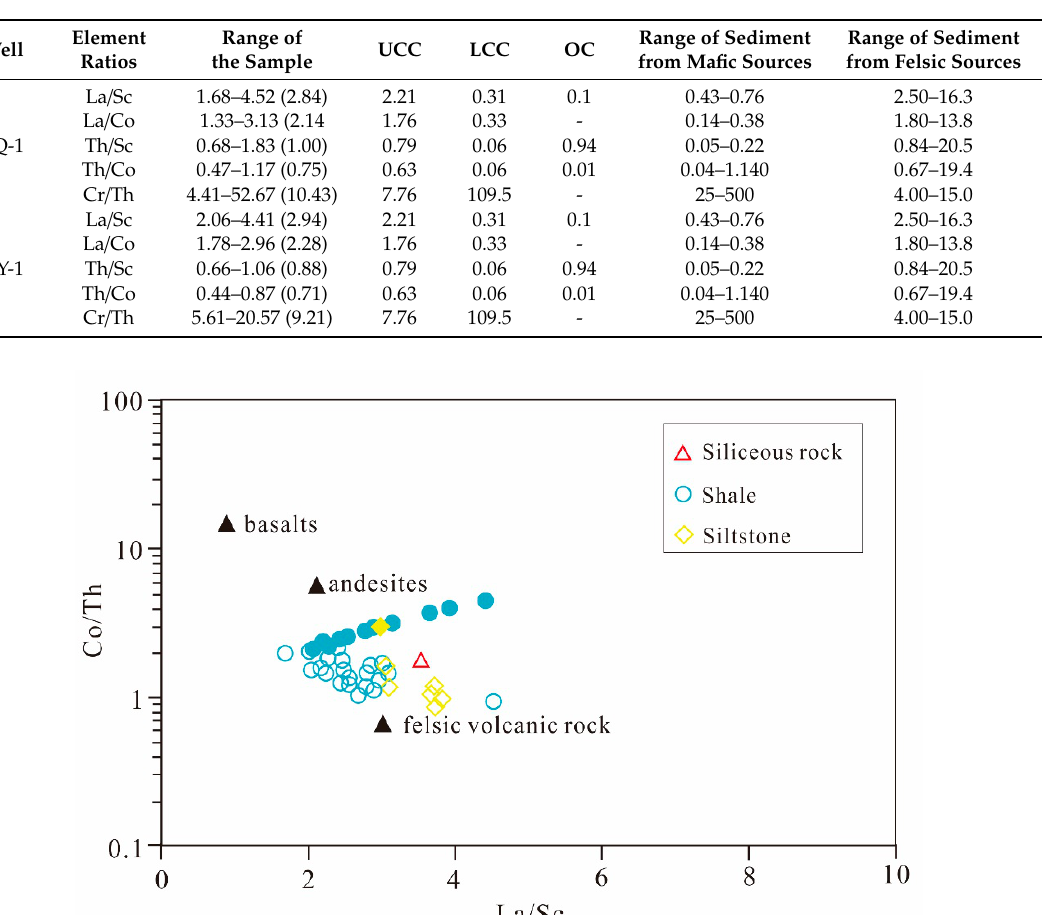
Figure 9. Source discrimination diagrams of Co/Th vs. La/Sc. Hollow points are the samples from SQ-1 and solid points are the samples from CY-1.